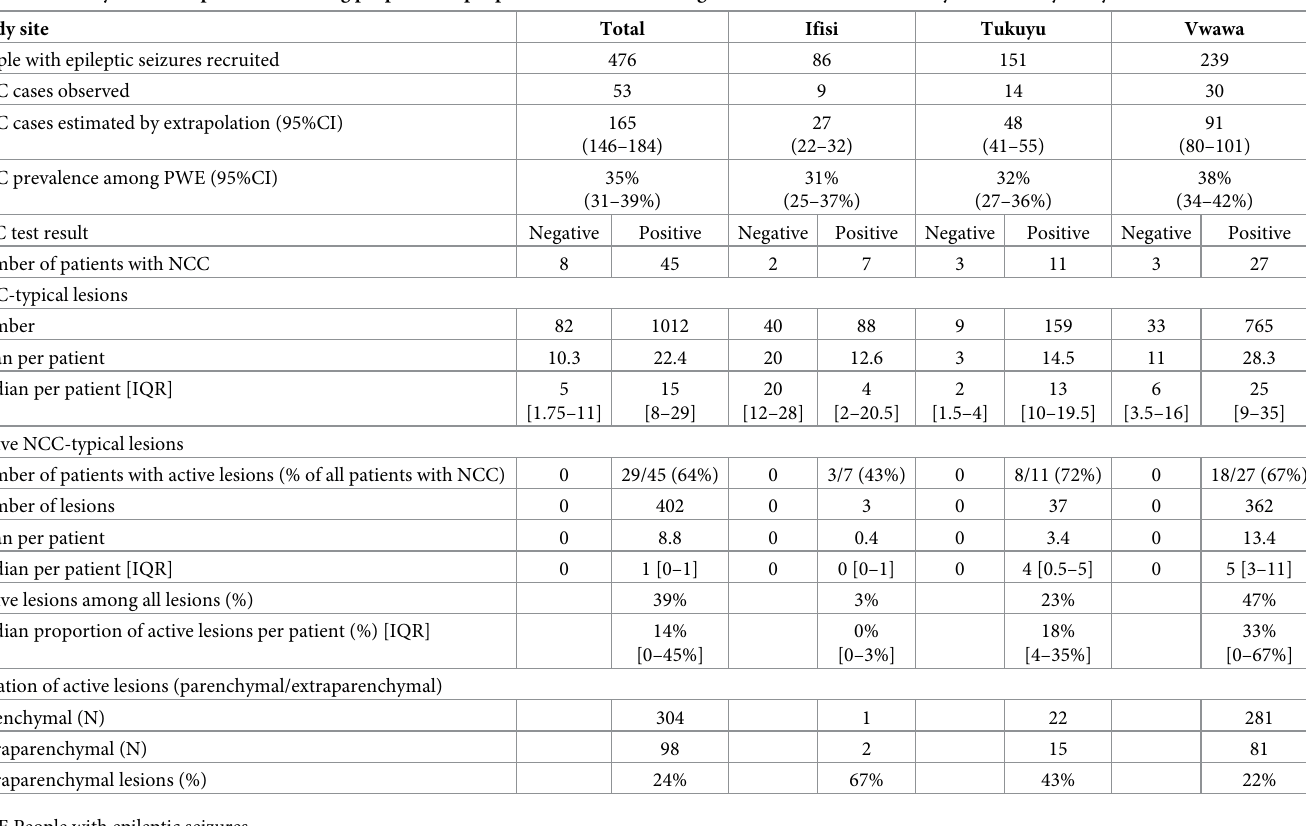
Table 2. Neurocysticercosis prevalence among people with epileptic seizures and radiological characteristics of neurocysticercosis by study